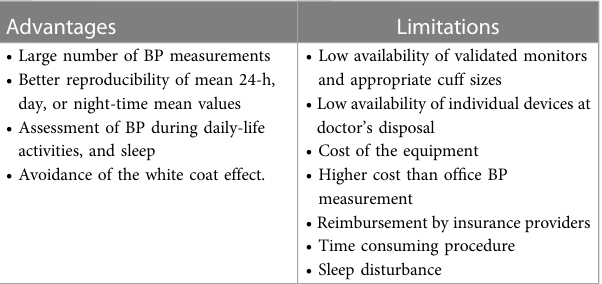
TABLE 6 Advantages and limitations of 24-h ambulatory blood pressure monitoring vs. of fi ce blood pressure. Advantages